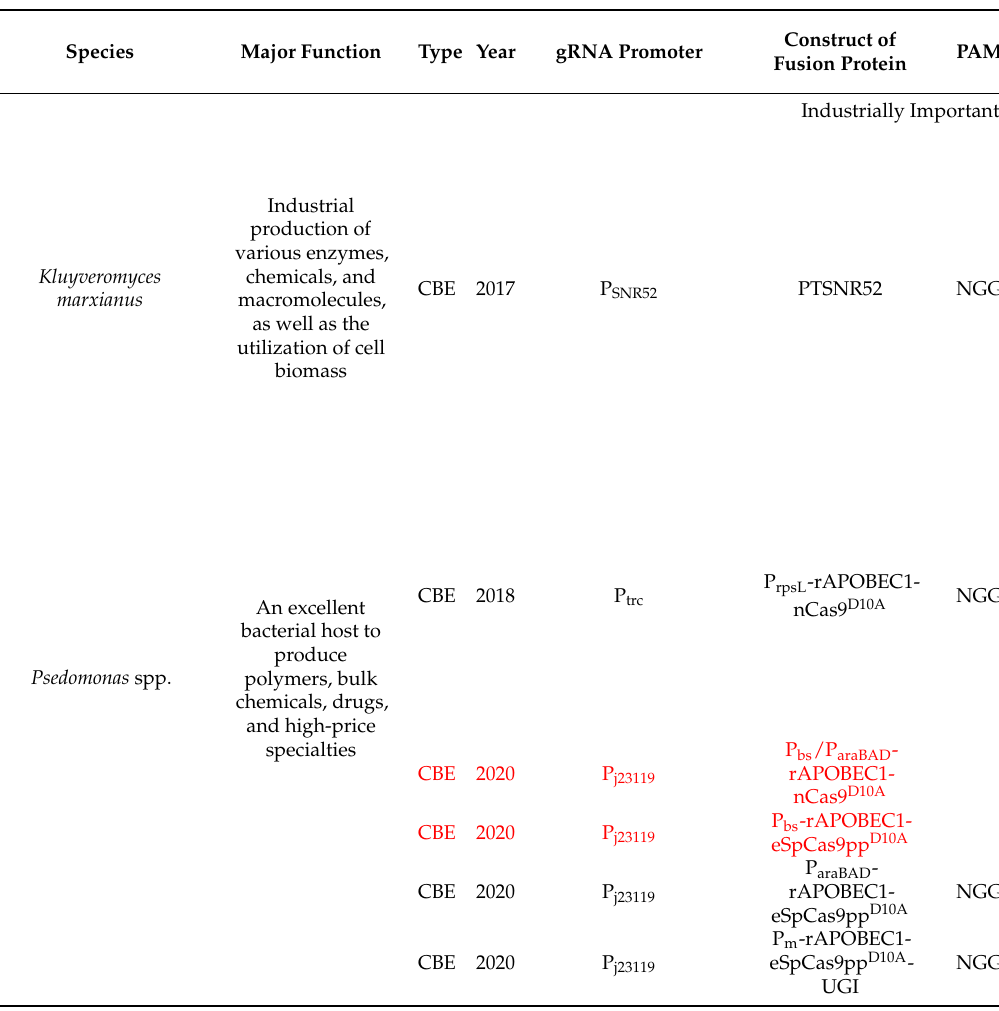
Table 2. The Characteristics and Applications of BEs in Nonmodel